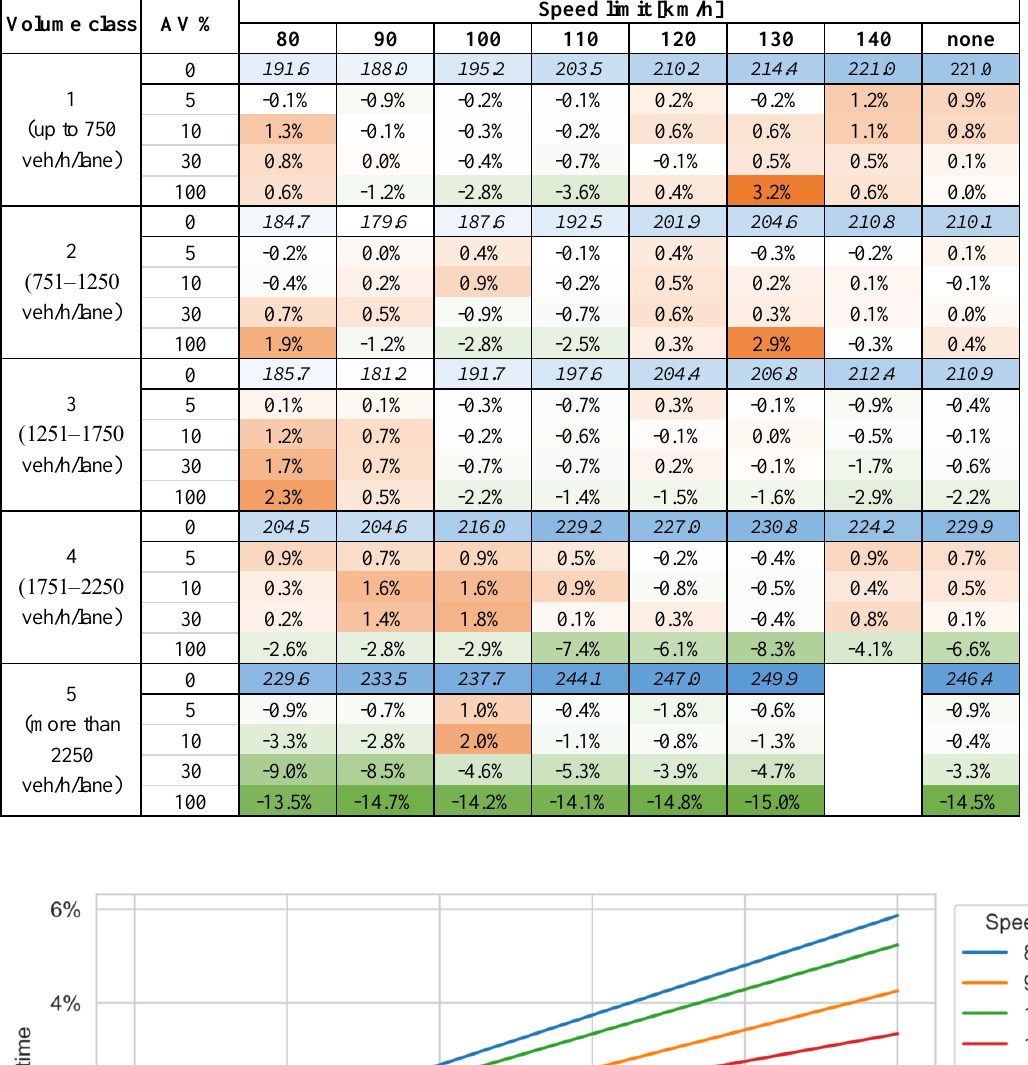
Table 11. Average CO 2 emissions in grammes per VKT at baseline and changes with